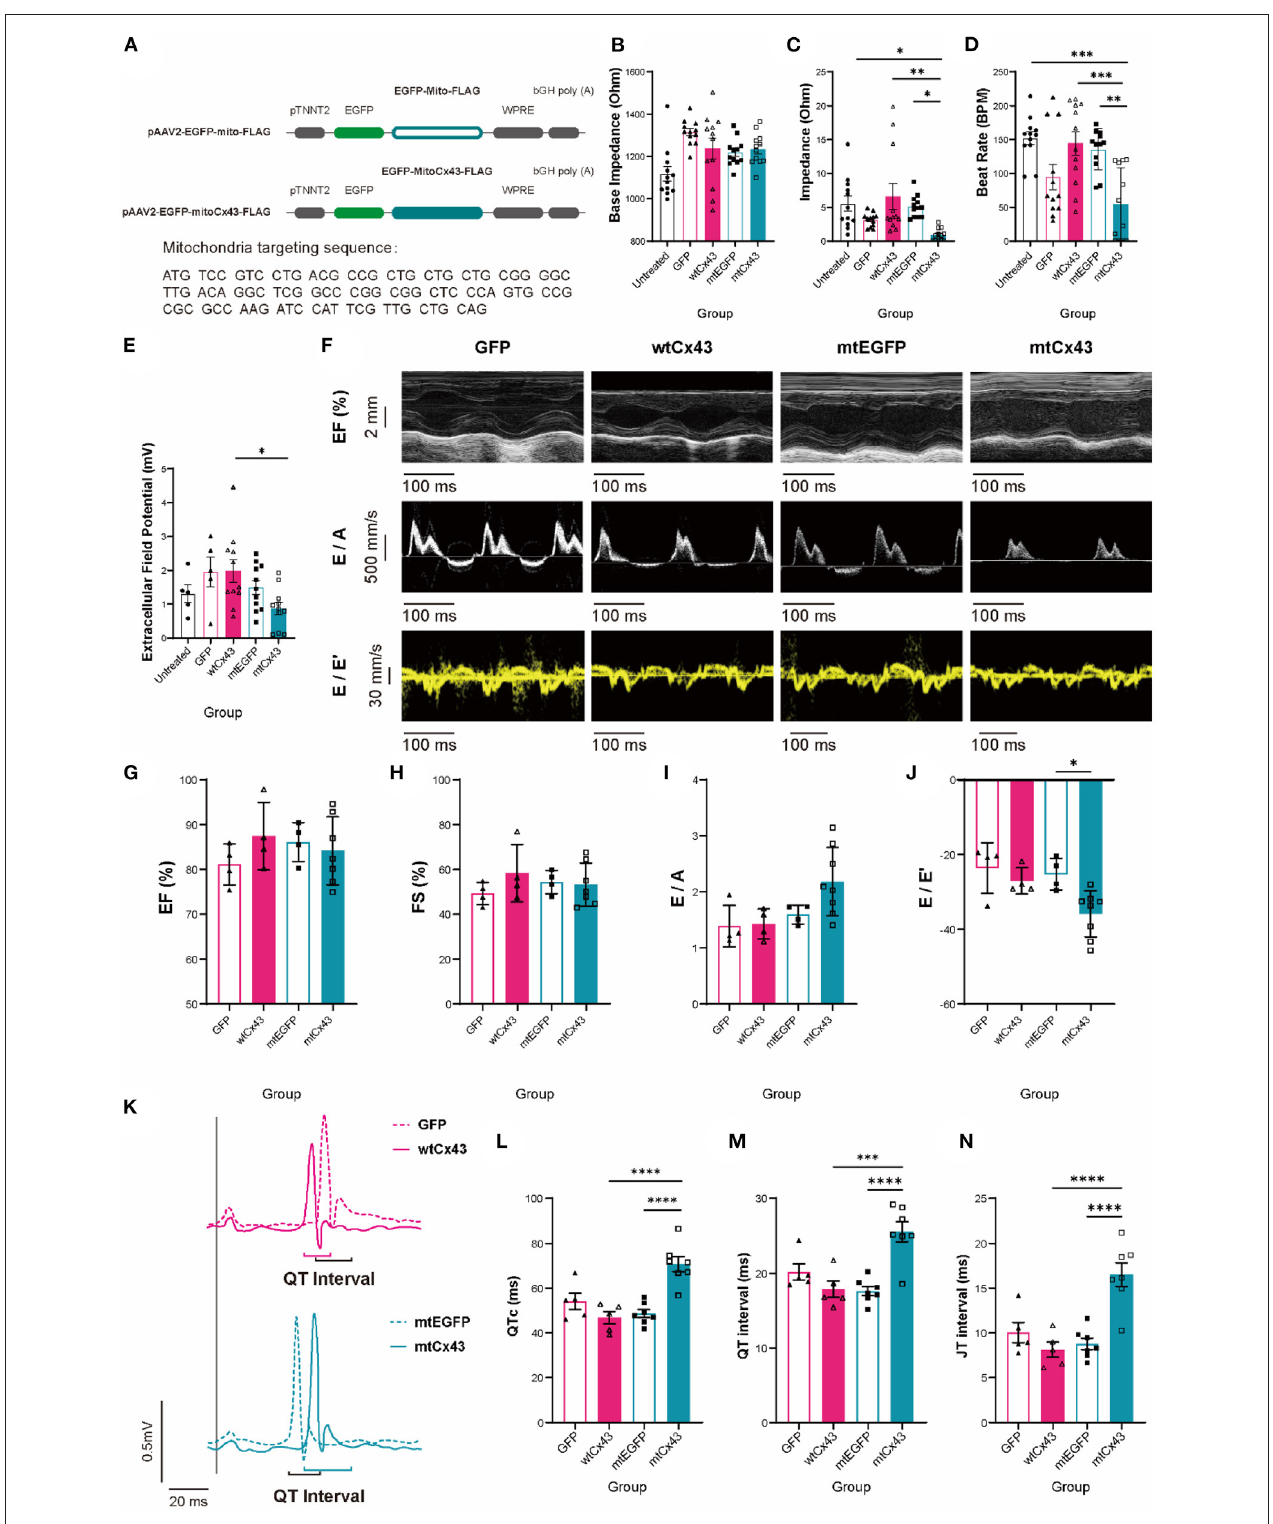
FIGURE 9 | Mitochondrial Cx43 overexpression causes aberrant cardiac contraction, electrophysiological abnormalities, and increased fatal arrhythmias susceptibility. (A) Recombinant p-AAV vectors of mito-GFP-FLAG and mito-Cx43-FLAG. (B–E) Base impedance [ (B) , n = 12 wells per group], amplitude [ (C) , n = 12 wells for